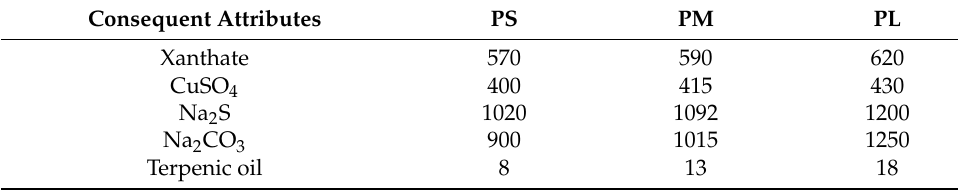
Table 2. Output referential values of consequent attributes in gold flotation (mL/min).